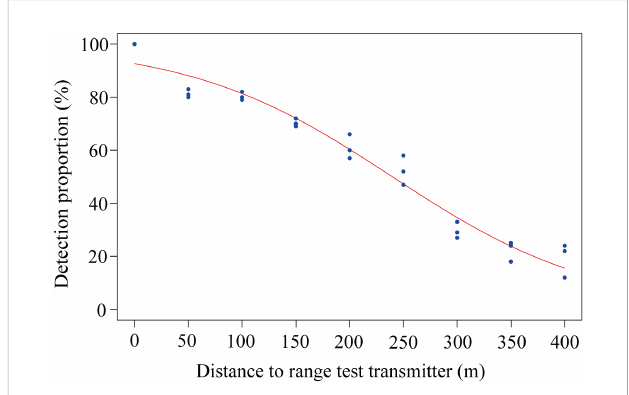
FIGURE 4 Detection proportion pro fi les of the 1-h range test in experiment I. Blue dots represent the observed detection proportion per 20 min (n = 3). Red line represents the logistic curve.